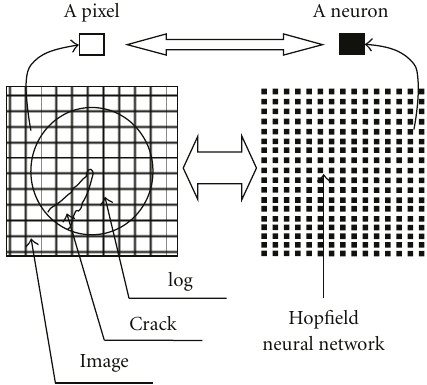
Figure 5: The diagram of the relationship between the wood image and the Hopfield neural network structure. Every pixel in the left image is represented by a neuron in the right network structure.